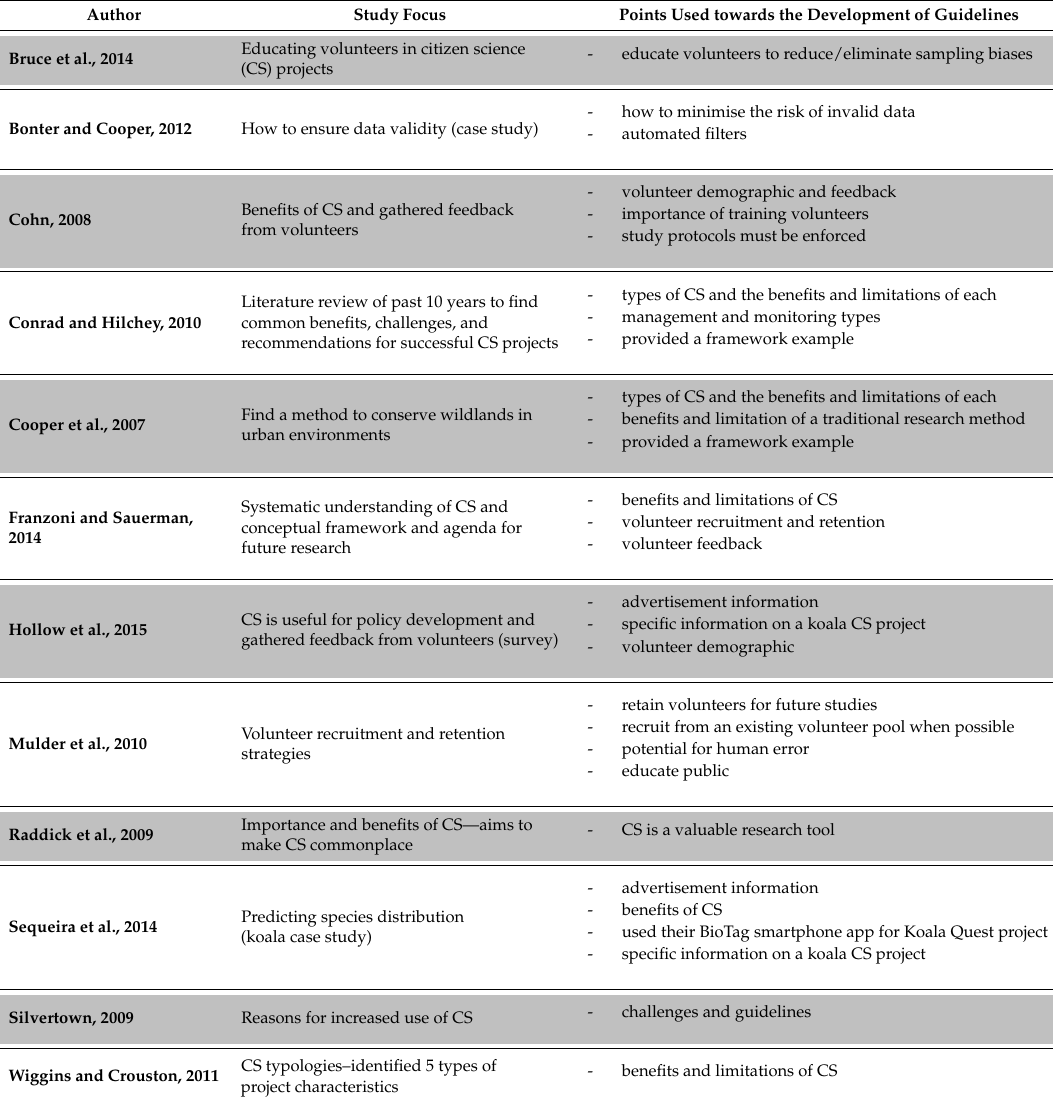
Table 1. Studies reviewed for the development of guidelines for a small-scale citizen science